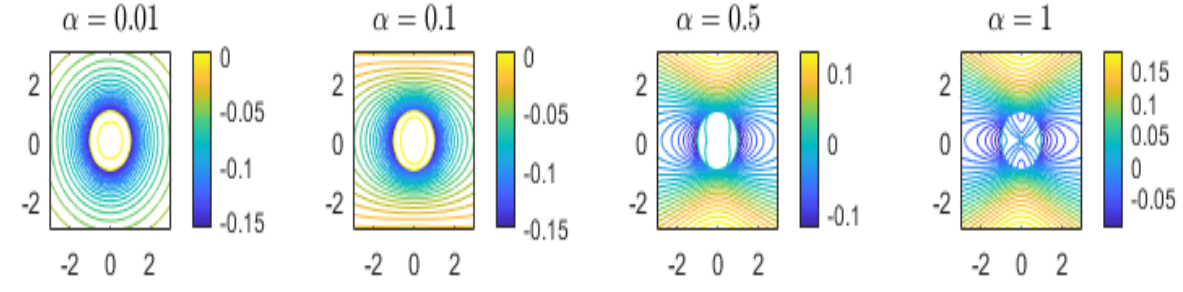
Figure 1. Streamlines at different α and ω = 1 for case 1 (damping